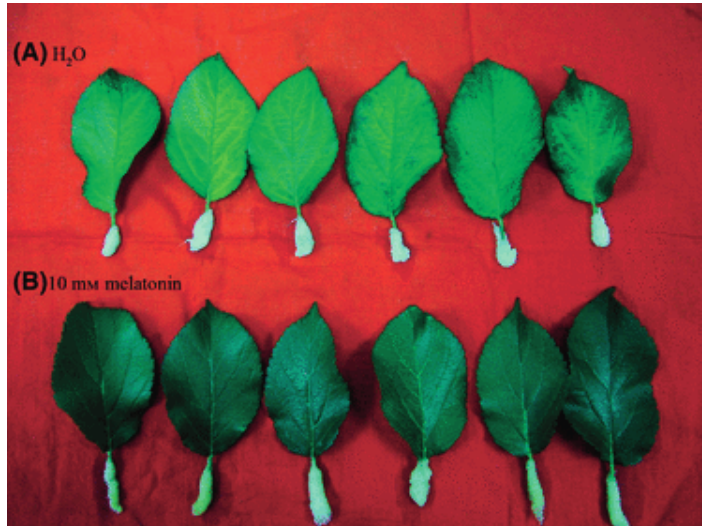
Figure 8. Detached apple leaves treated with ( A ) water only (H 2 O) or with ( B ) water containing melatonin (10 mM melatonin) and kept in the dark for 12 days. Melatonin delayed senescent changes in the leaves as illustrated by the preserved chlorophyll levels. From Wang et al. [154] with